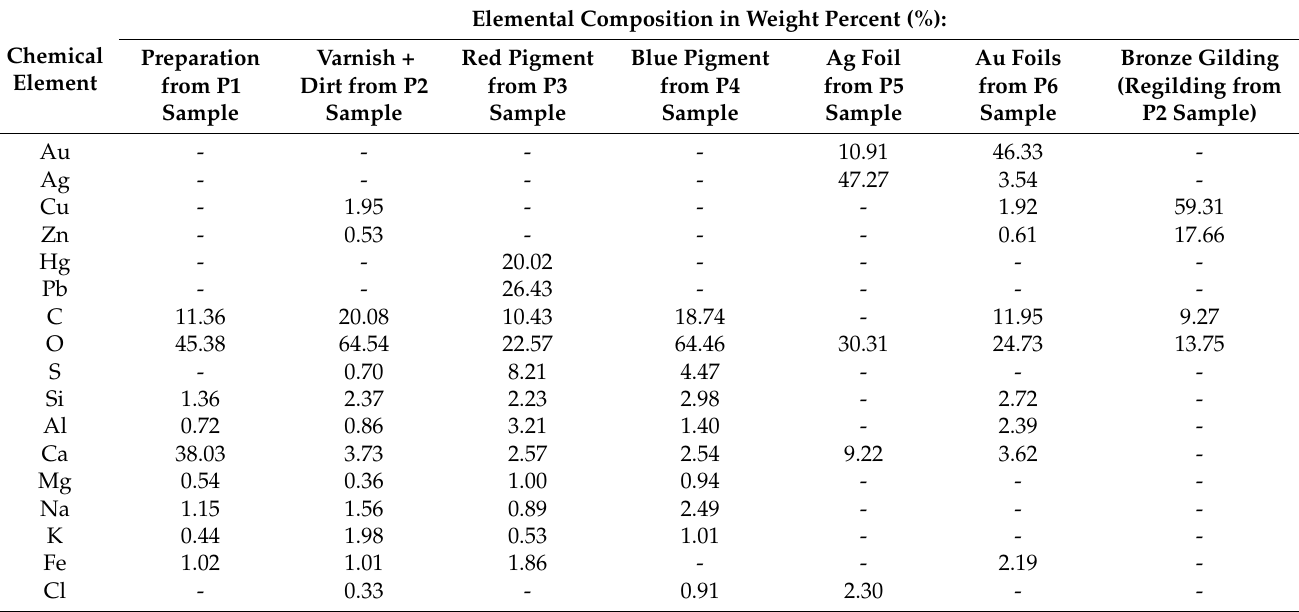
Table 1. EDX elemental composition of the analyzed samples of pictorial materials and